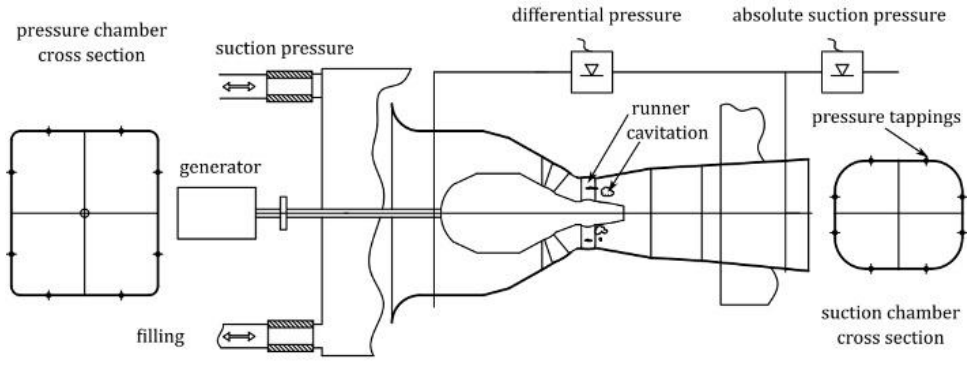
Figure 5. Turbine measuring station.